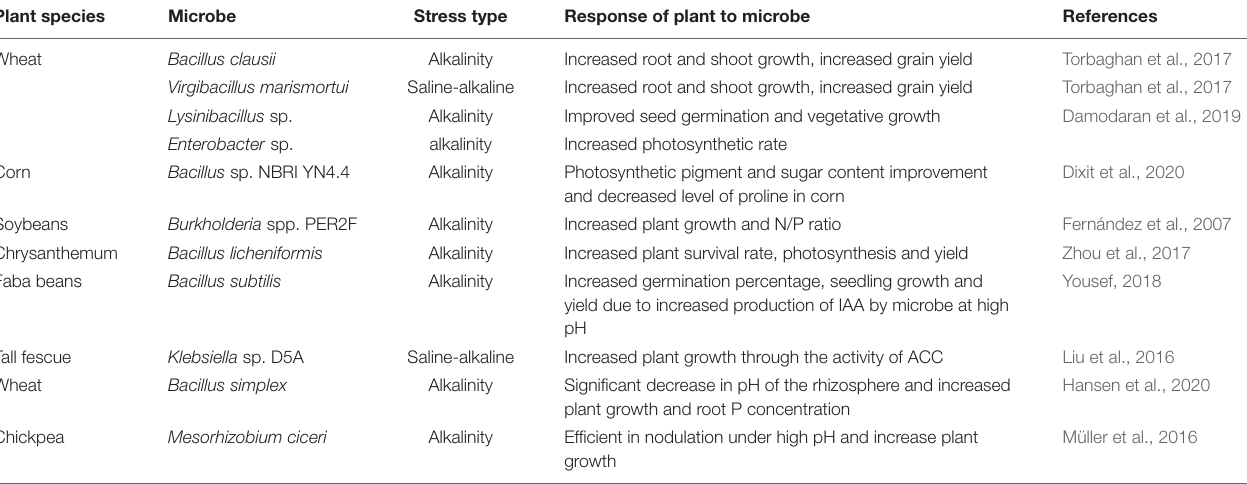
TABLE 2 | Effectiveness of PGPM on plants growth under alkalinity